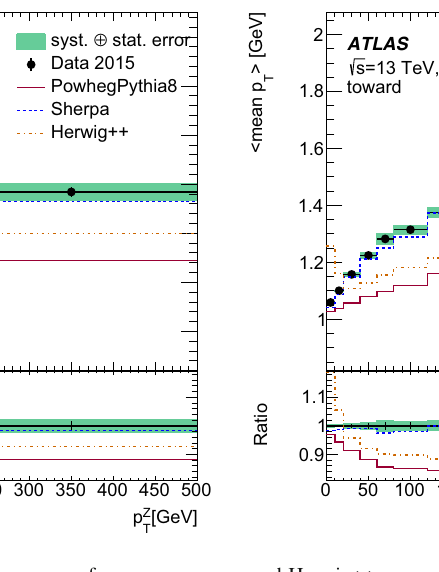
and Herwig++ are compared with the data. The ratios shown are pre- dictions over